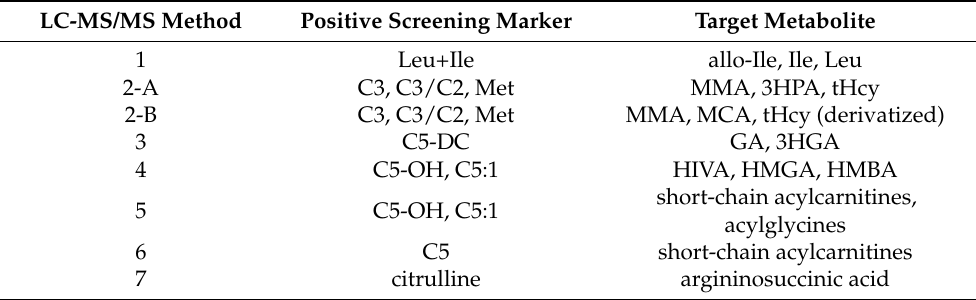
Table 1. LC-MS/MS methods for the metabolites related to the screening